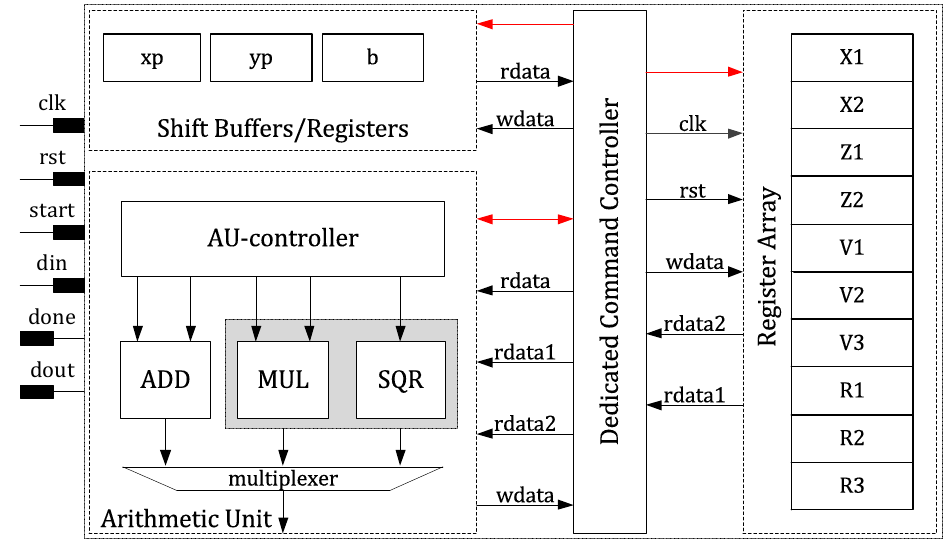
Figure 2. Proposed Hardware Accelerator Architecture of